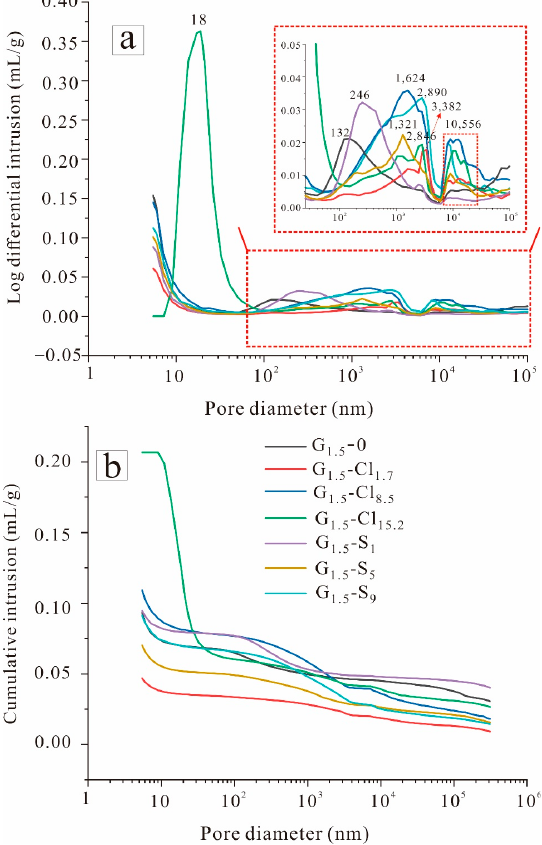
Figure 12. MIP results of geopolymers: ( a ) log differential intrusion and ( b ) cumulative intrusion.